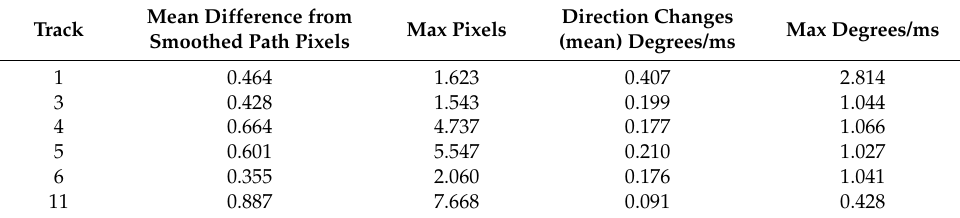
Table 4. Analysis of six Schistosoma mansoni miracidia trajectories in video recording (see Figure 2). Direction Changes Mean Difference from Max Pixels Track Smoothed Path Pixels (mean)